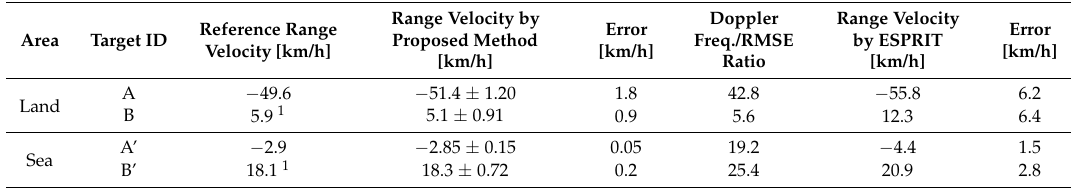
Table 3. Summary of application